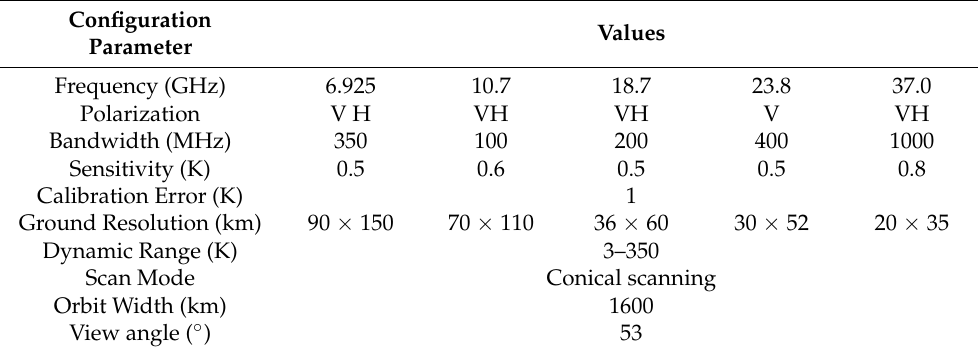
Table 2. Specifications of the HY-2B SMR instrument.